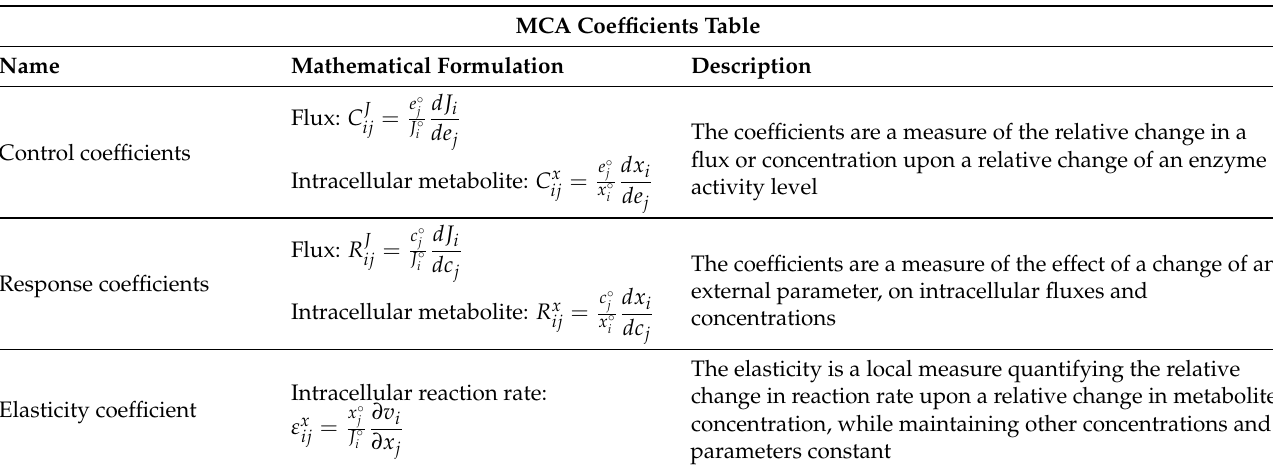
Table 2. The main Metabolic Control Analysis (MCA)